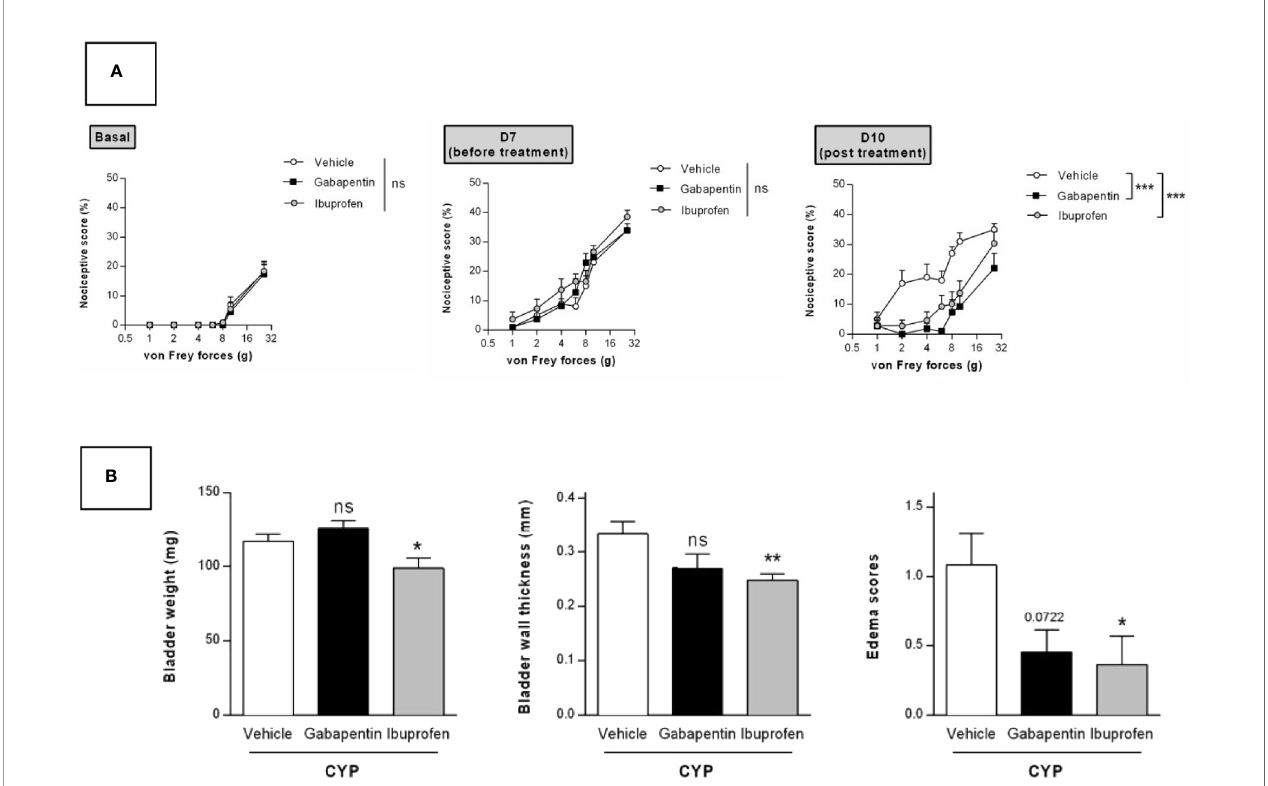
FIGURE 6 | Validation of the model by curative oral treatment of clinically relevant compounds. Rats received three injections of CYP (40 mg/kg, i.p.) on days 0, 3, and 6. Rats were randomized and treated with three oral administrations of either ibuprofen (100 mg/kg) or gabapentin (100 mg/kg) or vehicle (10 ml/kg) on days 8, 9, and 10. (A) Nociceptive response was assessed by von Frey testing at day 7, once the cystitis was established but before treatment start (Before), and at day 10, 1 h after the last treatment (Post). Nociceptive score was expressed as the percentage of the maximal score for each von Frey force. (B) Bladder in fl ammation was assessed at day 10 by measuring bladder weight, wall thickness and edema scores. Data represent mean values ± SEM (n = 11 for CYP and n = 12 for Gabapentin and Ibuprofen). ns p > 0.05, *p < 0.05, **p < 0.01, ***p < 0.001 (two-way RM ANOVA). (A) Two-way RM ANOVA; (B) Mann Whitney or unpaired t